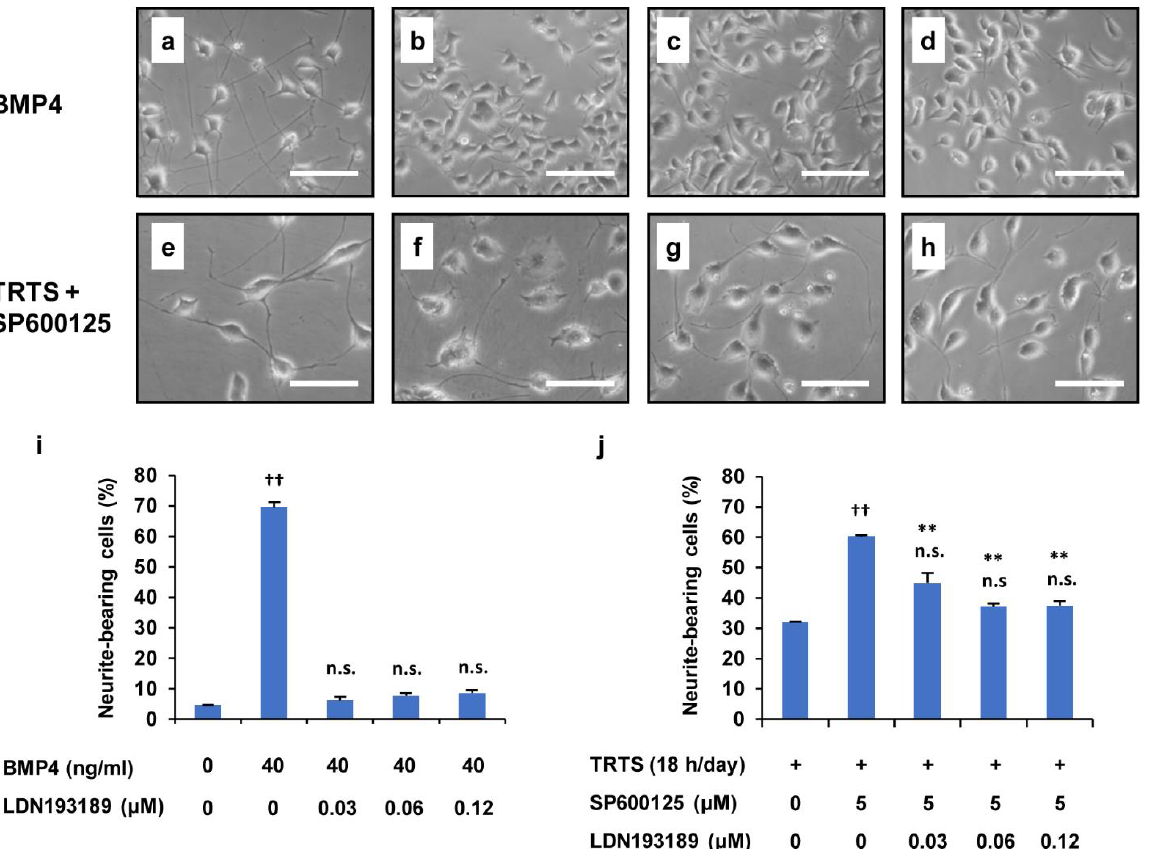
Figure 9. Suppression of TRTS plus SP600125-mediated neuritogenesis by LDN193189 in PC12-P1F1 cells. ( a – d ) PC12-P1F1 cells were treated with 40 ng/mL BMP4 as a control for 7 days in the presence or absence of LDN193189. Representative phase-contrast images of PC12-P1F1 cells on day 7 after treatment with ( a ) 0 μM , ( b ) 0.03 μM, ( c ) 0.06 μM, and ( d ) 0.12 μM LDN193189. ( e – h ) PC12-P1F1 cells were exposed to TRTS plus SP600125 for 7 days in the presence or absence of LDN193189. Representative phase-contrast images of PC12-P1F1 cells on day 7 after treatment with ( e ) 0 μM , ( f ) 0.03 μM, ( g ) 0.06 μM, and ( h ) 0.12 μM LDN193189. Scale bars: 100 μm . ( i , j ) PC12-P1F1 cells were stimulated with 40 ng/mL BMP4 ( i ) or exposed to TRTS plus SP600125 ( j ) for 7 days, and the rate of neurite-bearing cells on day 7 was determined. The data represent the means ± standard deviation of three replicates. †† p < 0.01 vs. control ( i ) or TRTS alone ( j ); n.s., not significant vs. control ( i ) or TRTS alone ( j ); ** p < 0.01 vs. TRTS plus SP600125 only ( j ).